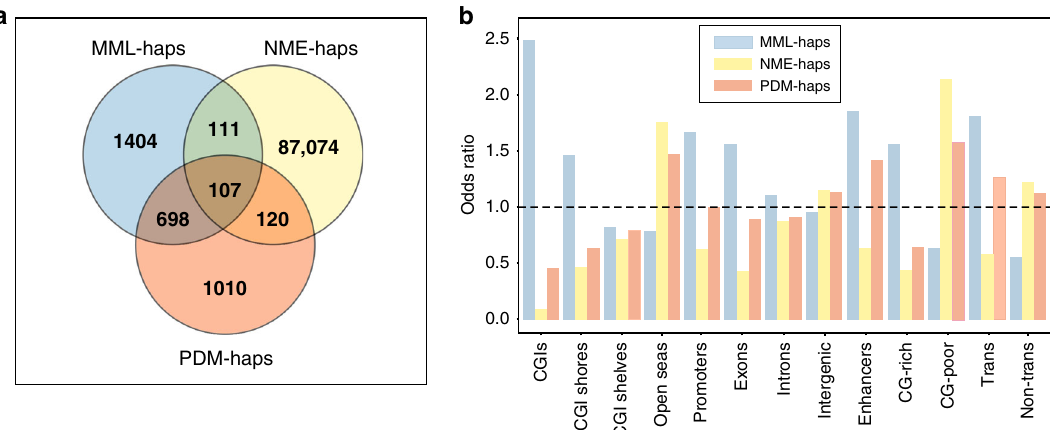
Fig. 5 Results of real data ASM analysis using the CPEL method. a Statistically signi fi cant haplotypes identi fi ed by the CPEL method across all tissues from the same individual in the real data and their speci fi c attributes. b Odds ratio statistic values of statistically signi fi cant haplotypes overlapping genomic features and regions of interest across all tissues from the same individual. A total of 1,459,967 haplotypes have been considered. OR > 1 indicates enrichment, whereas OR < 1 indicates depletion. MML-haps: haplotypes exhibiting signi fi cant imbalances in mean methylation level; NME-haps: haplotypes exhibiting signi fi cant imbalances in normalized methylation entropy; PDM-haps: haplotypes exhibiting signi fi cant differences between the probability distributions of methylation within homologous